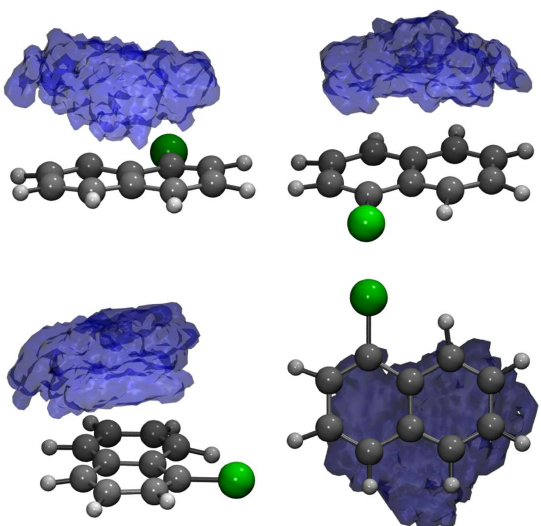
Figure 2. Side, front and top views of the spatial distribution function of the center-of-mass of the TCNE acceptor monomer around the 1ClN subunit.